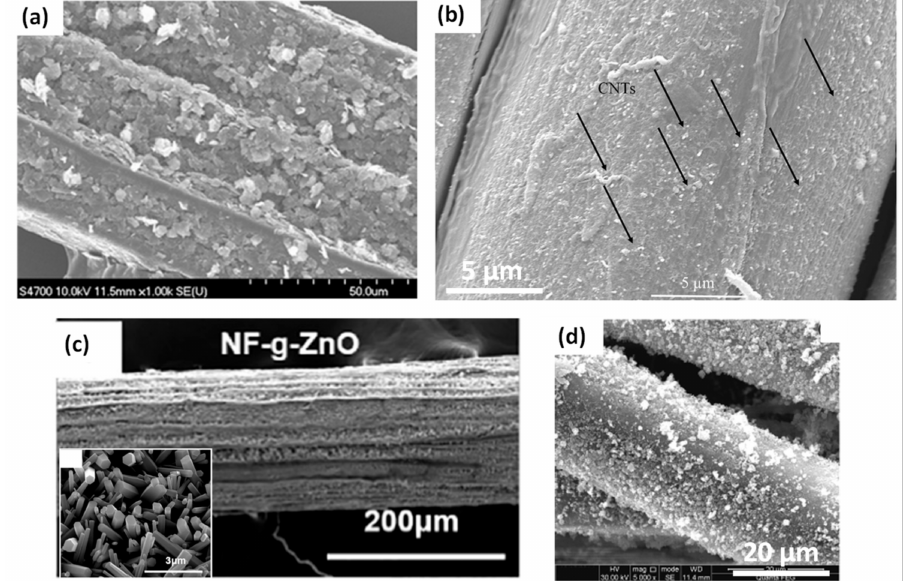
Figure 9. SEM images of hierarchical natural fibres ( a ) 5 wt% of graphite nanoplatelets (xGnP) coated on kenaf fibres, ( b ) 1 wt% carboxyl-functionalized CNTs (COOH-CNTs) coated on flax fibre yarns, ( c ) laterally-grown ZnO nanowires on sisal fibres, ( d ) 2.34 wt% grafted nano-TiO 2 on flax fibres of yarns (reprinted with permission from Han et al., 2012 [64], Li et al., 2015 [65], Yang et al., 2020 [66] and Wang et al., 2015